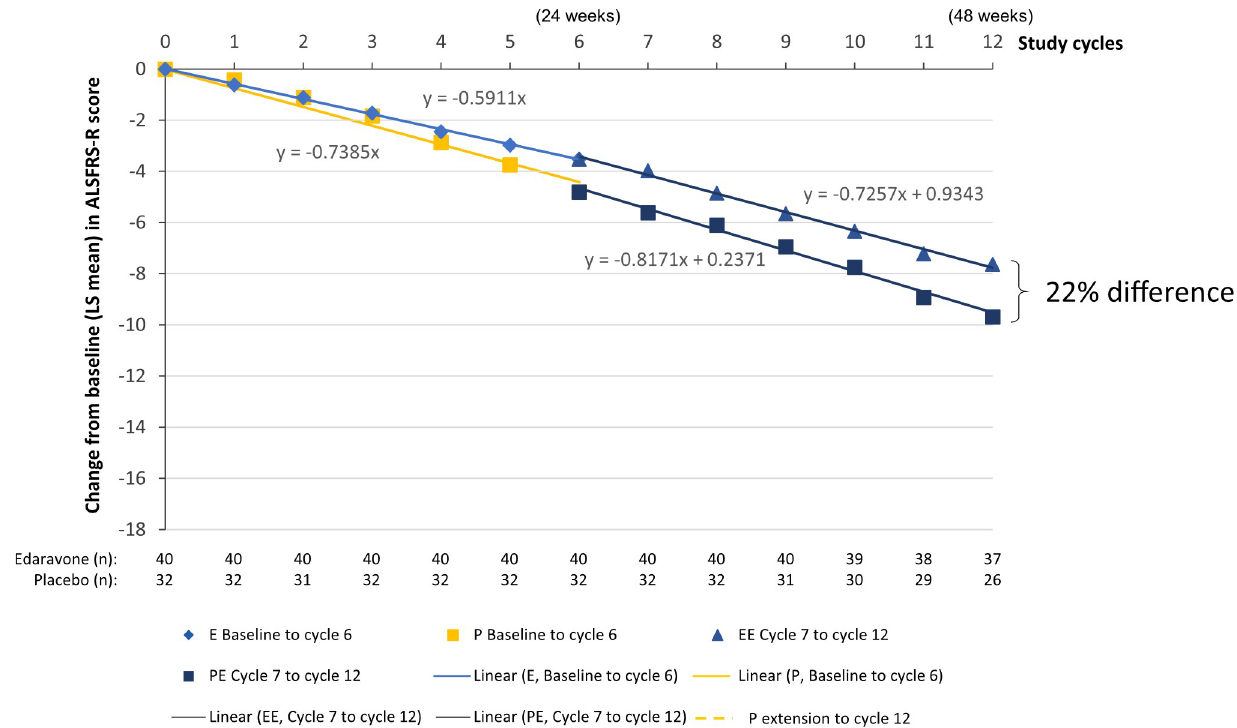
Fig 4. Regression analysis of change from baseline ALSFRS-R scores for the FVC 24 � 80%p subgroup. Symbols indicate treatment with edaravone (E, blue diamonds), placebo (P, yellow squares), edaravone-edaravone (EE, blue triangles), or placebo-edaravone (PE, blue squares). Data reflect LS mean change from baseline values. Linear regression line equations are shown on the graph. %p, percent of predicted; ALSFRS-R, Amyotrophic Lateral Sclerosis Functional Rating Scale-Revised; E, edaravone; FVC 24 , forced vital capacity in 24 weeks; LS, least squares; P, placebo.